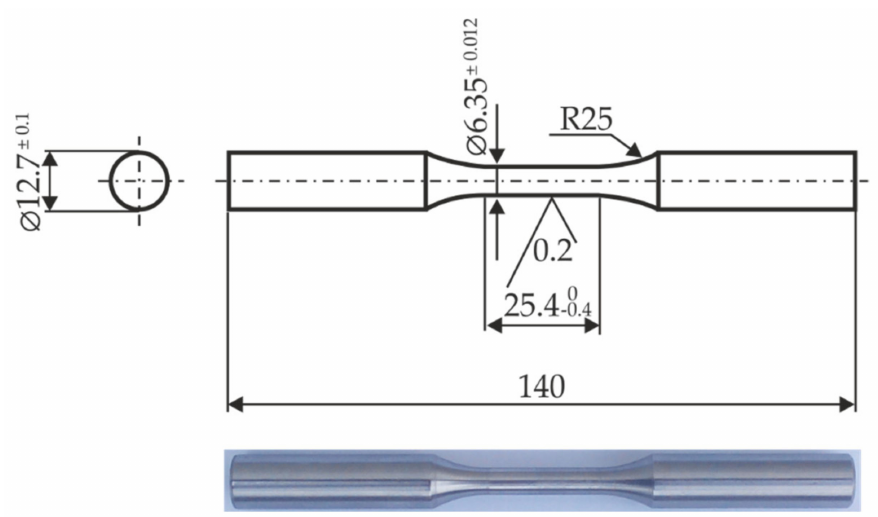
Figure 5. Technical drawing of fatigue testing specimen and real specimen (unit: